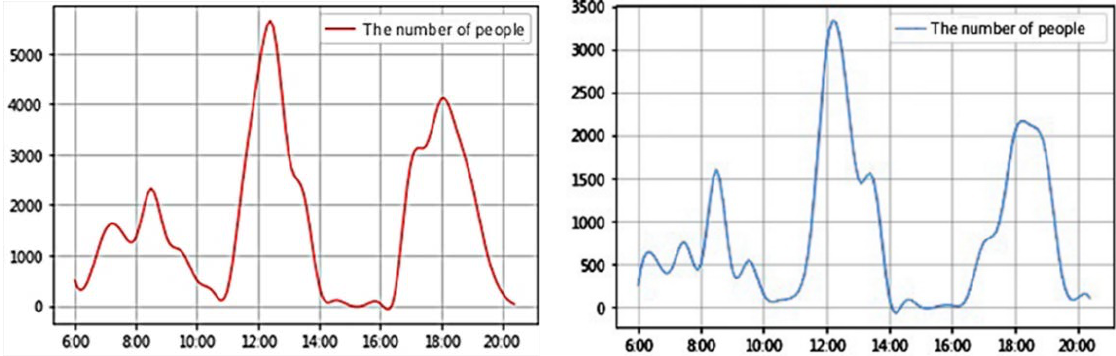
Figure 7. Peak travel flows from the classroom to other places (not the canteen) on working days and weekends.